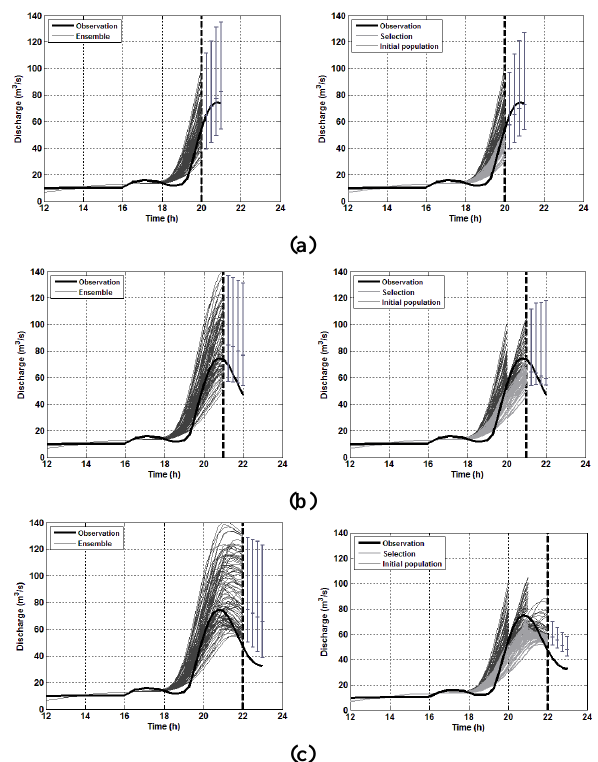
Fig. 8. Results of the forecast models for the April 2004 flood event. The vertical dashed line is the current time step. Forecasts are ex- pressed by the median and the prediction limits for a confidence level of 5%. The first column shows the results of the forecast model without data assimilation and the second column the forecast model with data assimilation. The rows show forecasts by current time step: (a) t = 20h; (b) t = 21h; (c) t =